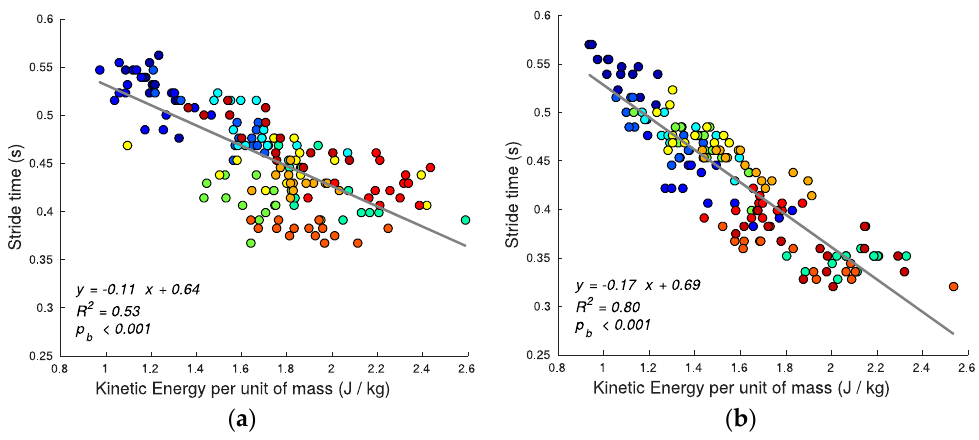
Figure 10. Kinetic energy per unit of mass kem and stride time t stride relationship for ascending ( a ) and descending ( b ) stairs. In stair ascent, a fraction of the kinetic energy is consumed in order to safely clear the nose of the treads.